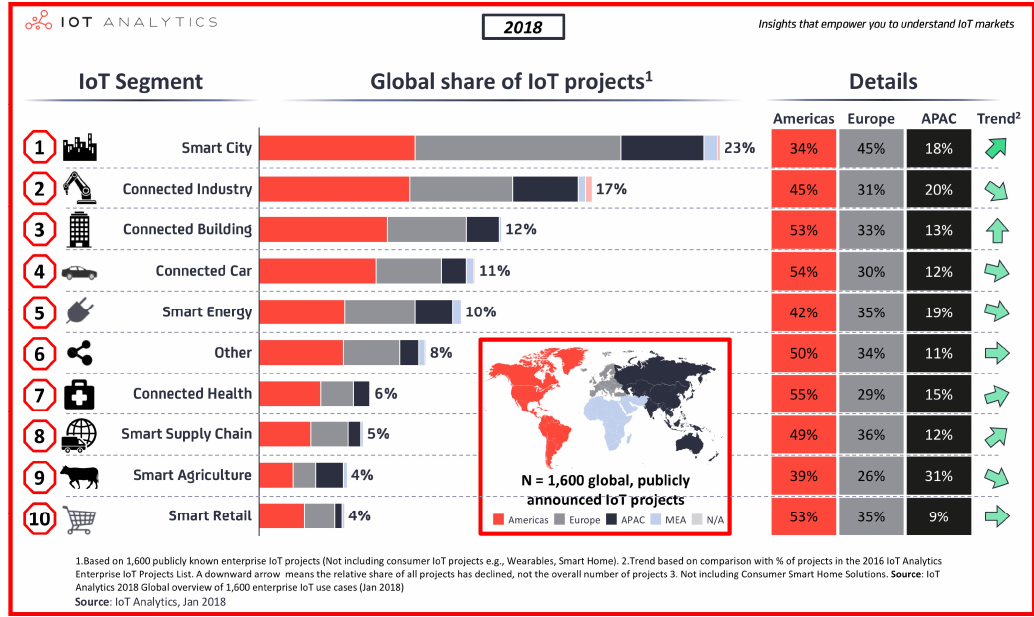
Figure 3. The top ten IoT Segments in 2018—based on 1600 real IoT projects [7].